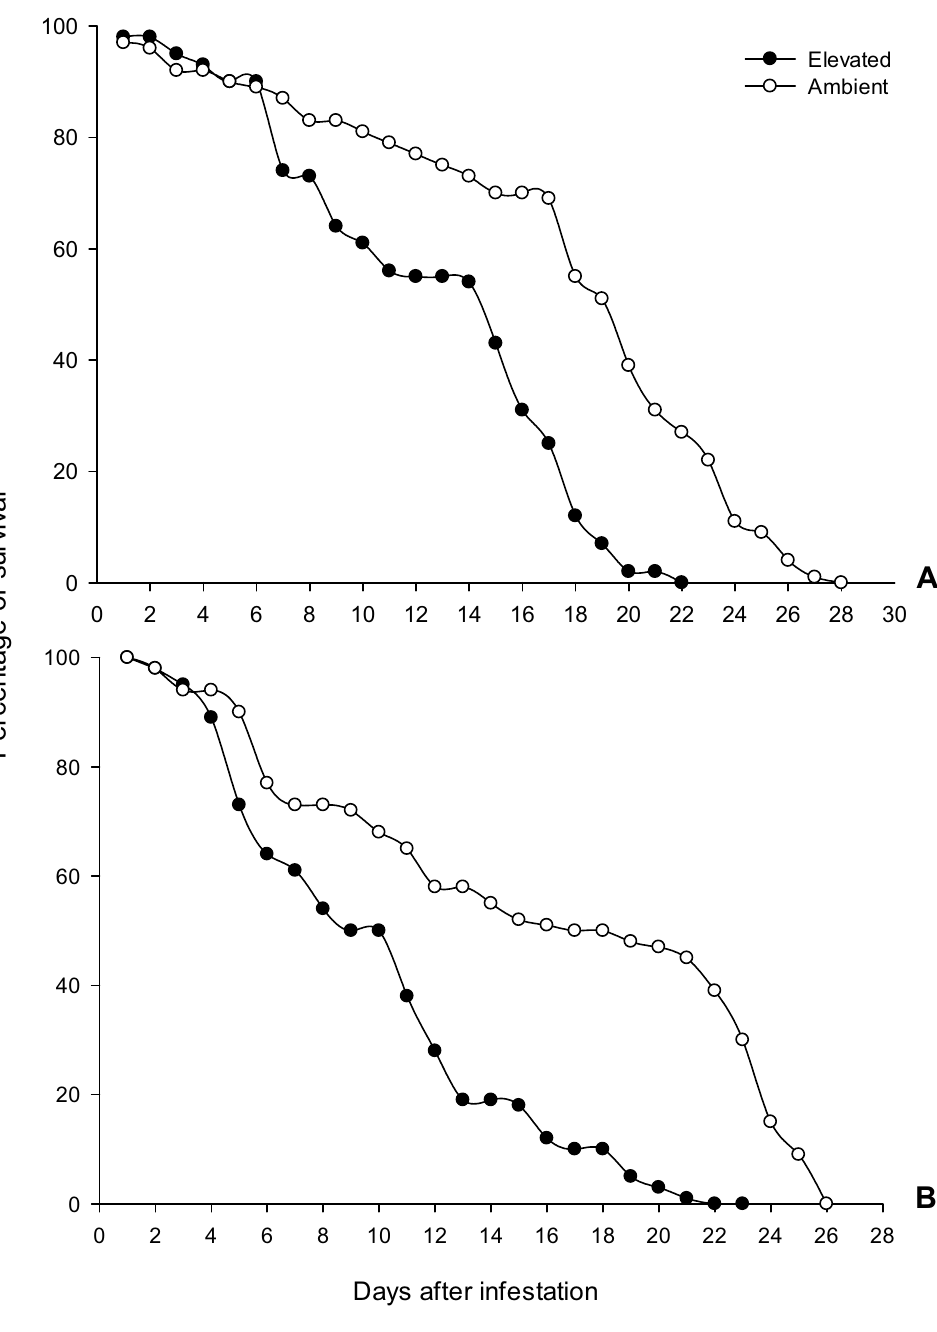
Figure 6. Survival rate of N. lugens on rice varieties (A-IR 20; B- ADT 46) grown in ambient and e CO 2 condition. Survivorship curves differ at the α = 0.05 confidence interval according to log-rank